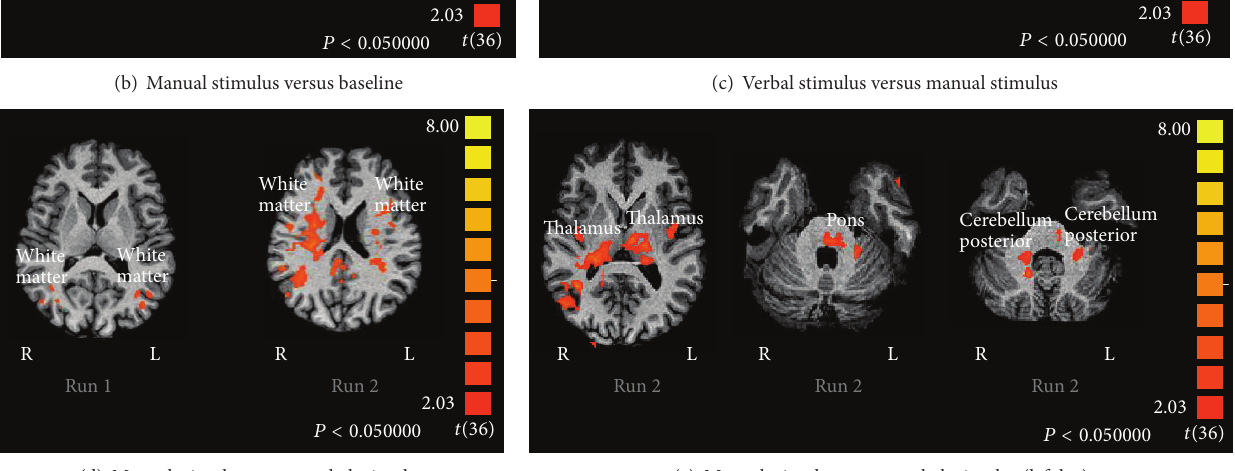
Figure 1: Statistical maps of activation for lower-limb movement. BA: Brodmann area; R: right hemisphere; L: left hemisphere; Run 1: right leg; Run 2: left